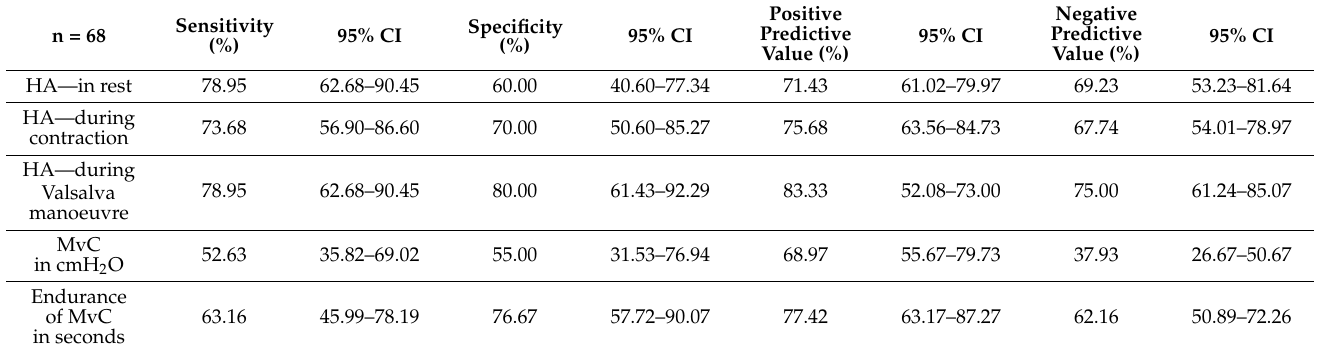
Table 5. Sensitivity, specificity and predictive values of pelvic floor muscle function and